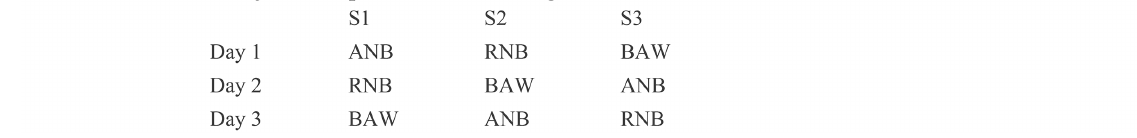
FIGURE 1 Schematic representation of the design of the study. (A) Design of the study, (B) Design of the n-back paradigm, (C) Order of the